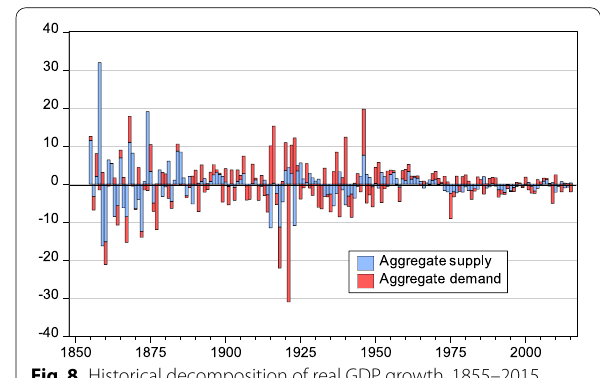
Fig. 8 Historical decomposition of real GDP growth, 1855–2015